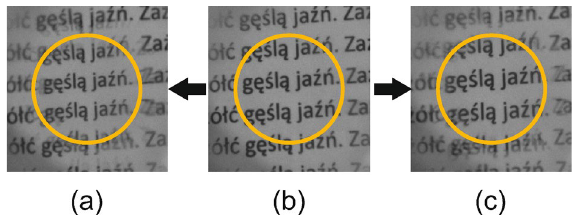
Figure 14. Different images of the lens performance ( a ) V 1 = 1.4 V RMS and V 2 = 4.5 V RMS (focused). ( b ) Lens switched off. ( c ) V 1 = 1.85 V RMS and V 2 = 0.6 V RMS